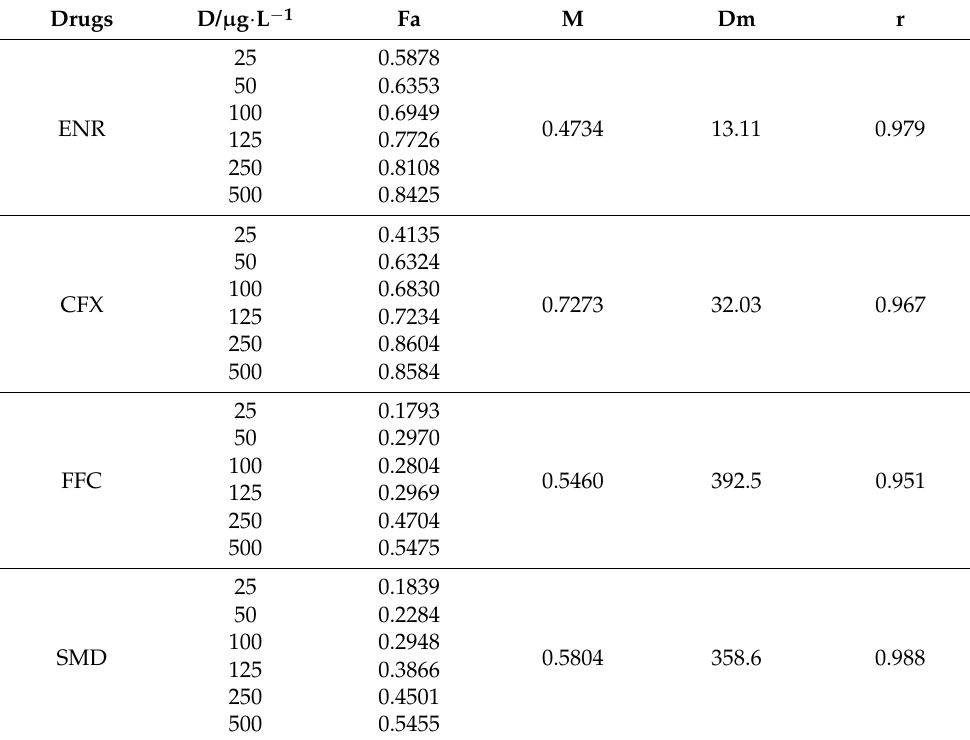
Table 2. Parameters of median-effect plots of enrofloxacin (ENR), ciprofloxacin (CFX), florfenicol (FFC), and sulfamethazine (SMD) for THLE-2 cells after 72 h incubation.